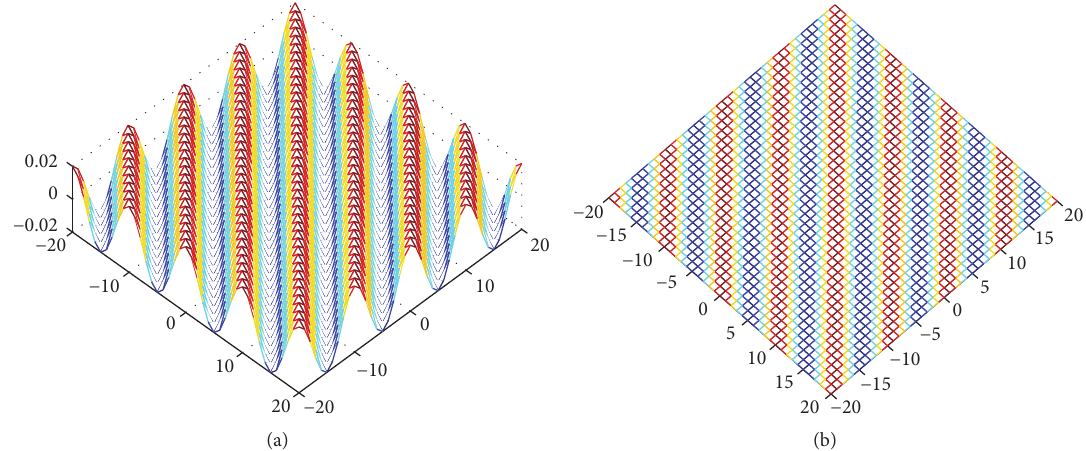
Figure 5: One quasi-periodic wave solution to (9) with the parameters 𝑘 = 0.1 , 𝑙 = 0.1 , 𝑎 = 0 , and 𝜏 = 𝑖 . Perspective view of the wave (a); overhead view of the wave (b), with contour plot shown. (The red lines are crests and the blue lines are